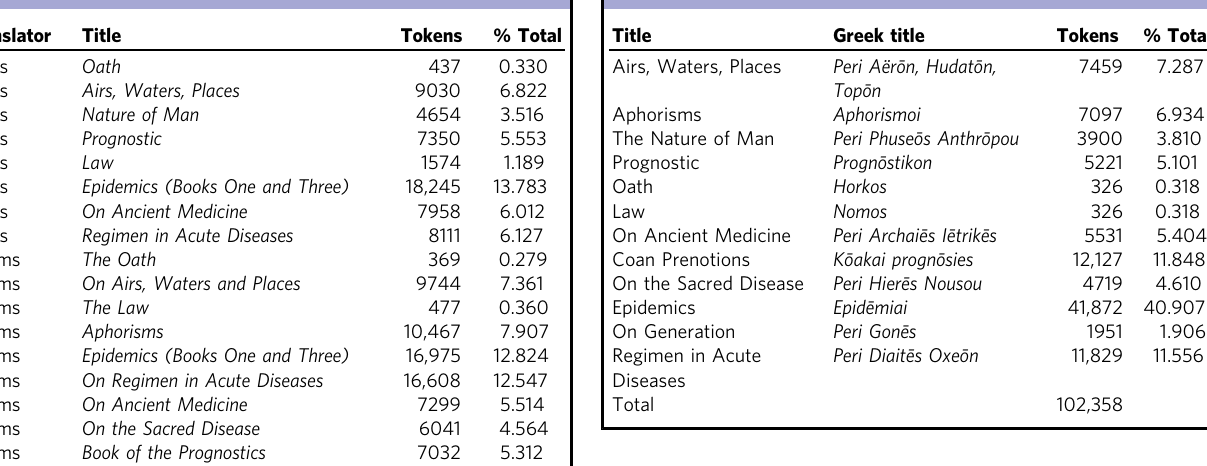
Table 1 Subcorpus description of the English core corpus. Table 2 Subcorpus description of the Greek core